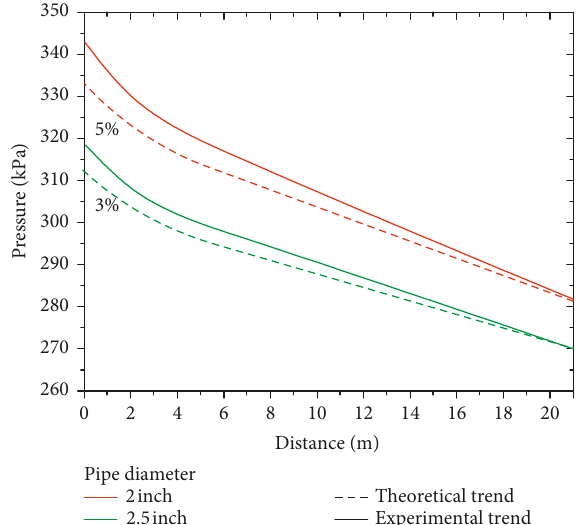
Figure 12: Pressure drop at different specifications of concrete